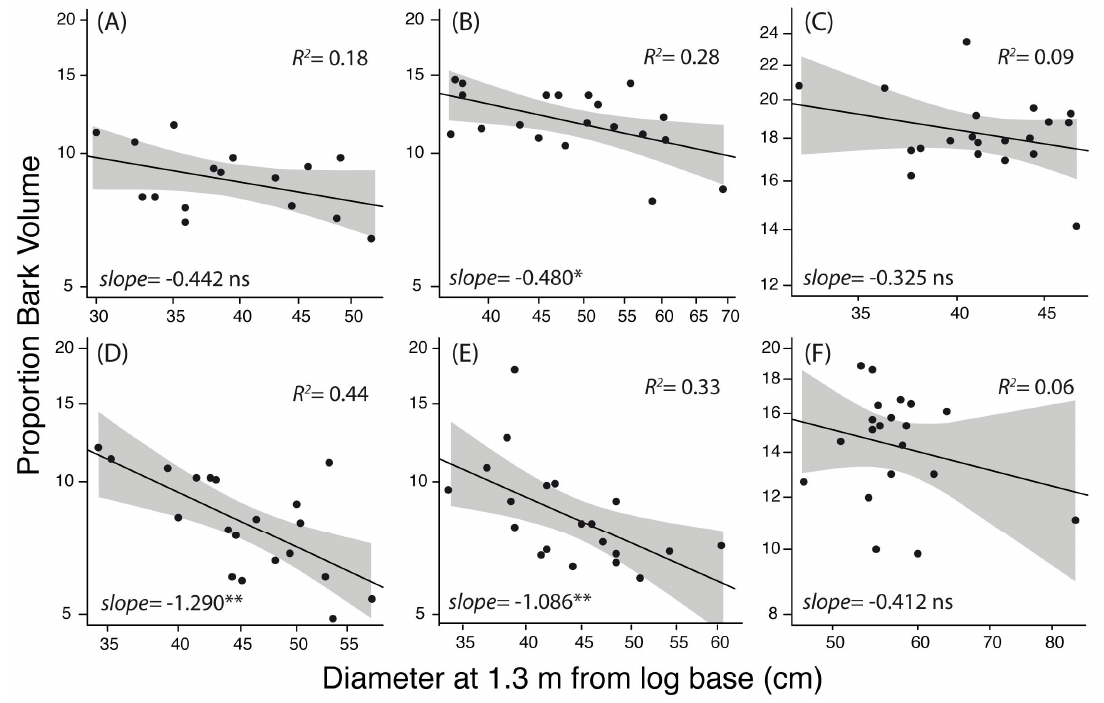
Figure 3. Change in the proportion of bark volume ( PBV ) with diameter at 1.3 m from the log base ( D b ). ( A ) Cordia dodecandra ; ( B ) Lysiloma latisiliquum ; ( C ) Manilkara zapota ; ( D ) Metopium brownei ; ( E ) Swartzia cubensis ; and ( F ) Swietenia macrophylla . In L. latisiliquum , M. brownei , and S. cubensis a decrease in the proportion of bark volume was observed with log size. Axes are log 10 transformed. In gray are the 95% confidence bands for linear fits. * p < 0.05, ** p < 0.01, ns non ‐ significant.